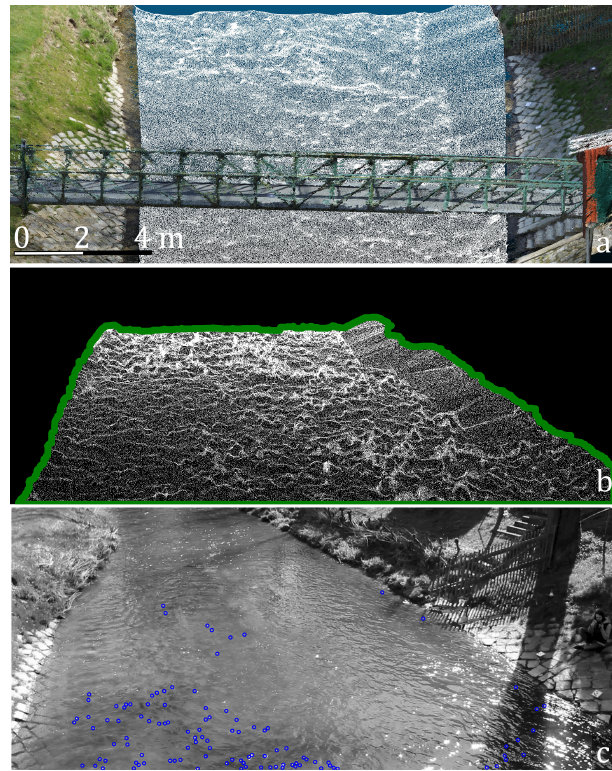
Figure 3. Defining the search area to extract particles to track. (a) 3D point cloud of the investigated river reach at the Wesenitz. Coloured points (colourised with RGB information according to their real-world object colour) are 3D points above the water sur- face reconstructed with SfM photogrammetry. White points are 3D points below the water surface reconstructed with SfM and cor- rected for refraction effects. (b) 3D point cloud below the water level projected into image space. Green line depicts contour line, which is used as search mask for feature detection. (c) Detected and filtered features considered for tracking (blue